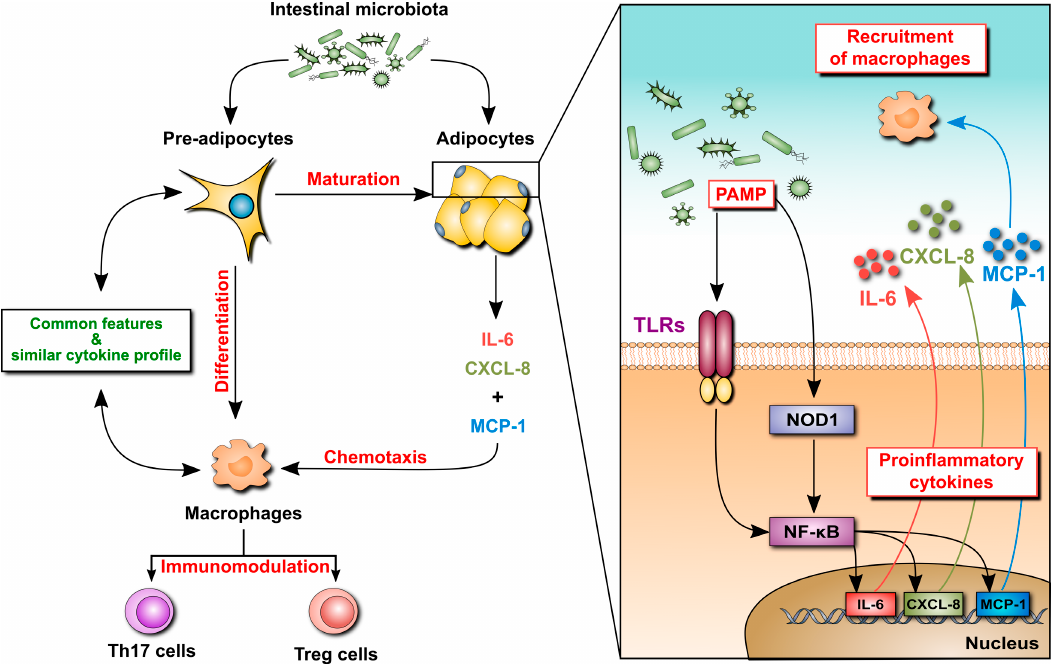
Figure 2. Potential mechanisms underlying the involvement of mesenteric adipocytes in the intestinal inflammatory response in inflammatory bowel disease (IBD). Pre-adipocytes in the mesenteric fat respond to translocated intestinal bacteria by sensing microbe-derived molecules (pathogen-associated molecular patterns, PAMP) with pattern recognition receptors, such as toll-like receptors (TLRs) or nucleotide oligomerization domain receptor-1 (NOD1). The resulting signaling cascades lead to activation of transcription factors (such as NF-kappa B) and induction of genes for proinflammatory cytokinesandchemokines. Thisleadstoadiposetissueinfiltrationbyleukocytes, includingmacrophages that modulate local inflammation and immune response. In addition, pre-adipocytes can di ff erentiate into macrophages further driving the inflammatory